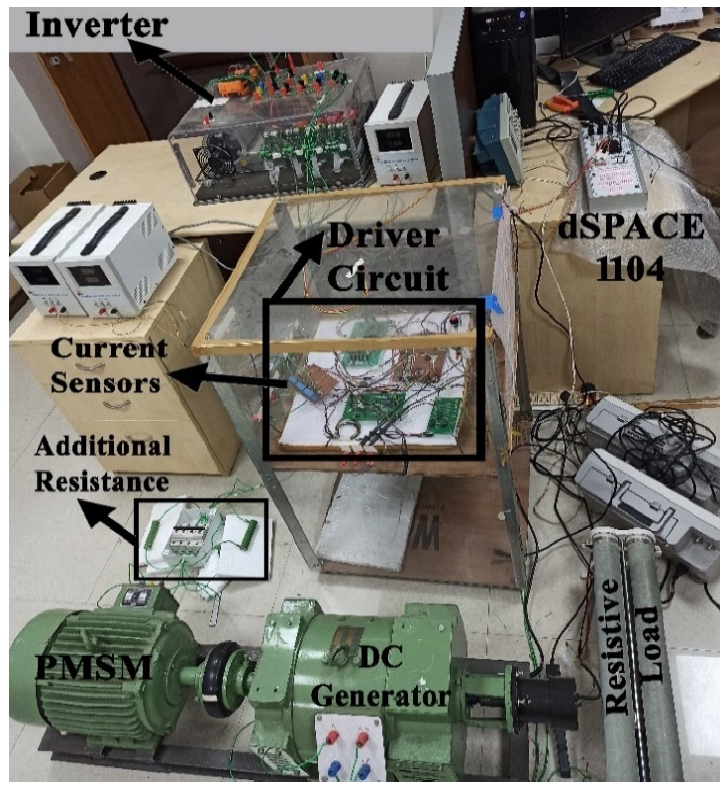
Figure 10 . Experimental setup. Figure 10. Experimental